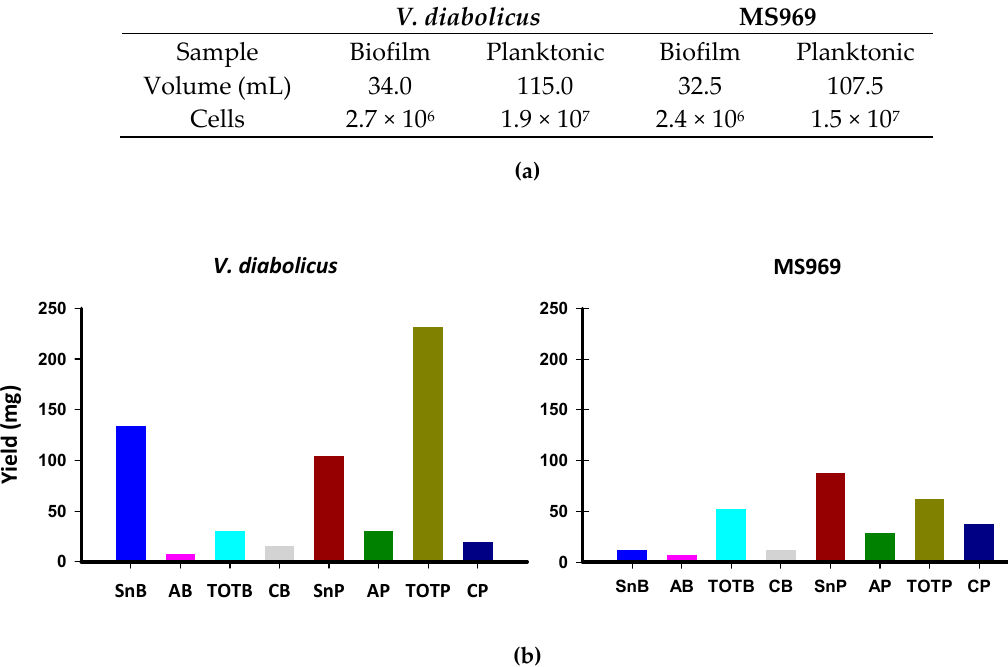
Figure 4. Recovery yield of each extract from 15 Petri dishes. ( a ) Amount of recovered cells. ( b ) Yield (mg) recovered after freeze drying or evaporation calculated for the whole biofilm or planktonic